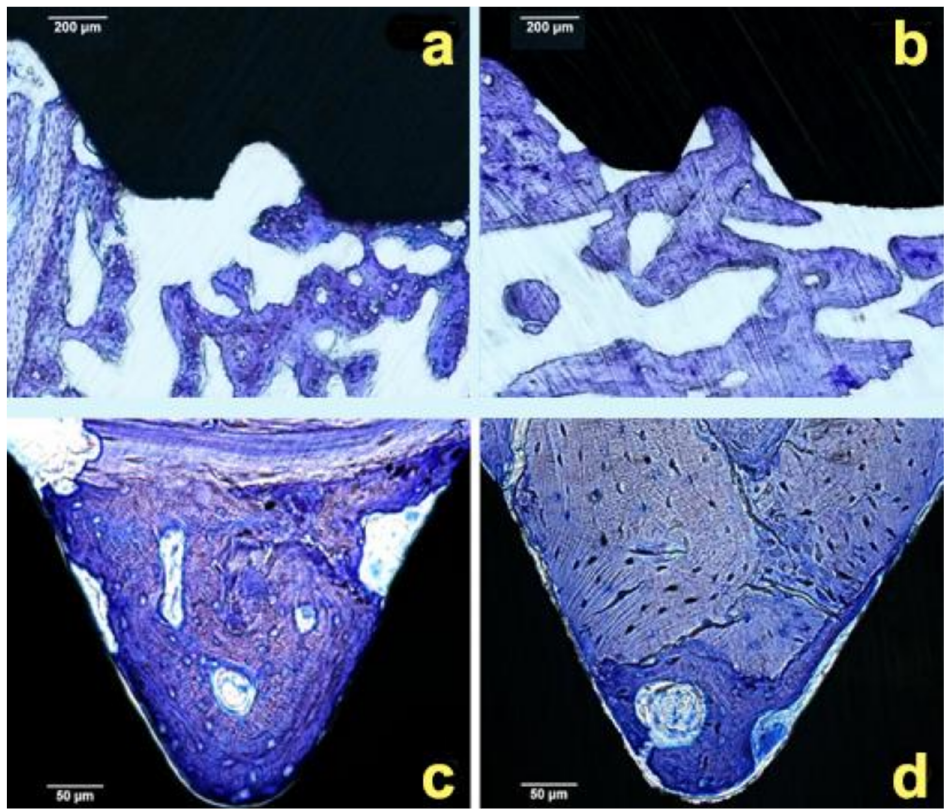
Figure 4. Bone healing proximal to the Ti ( a ) and APTES-coated ( b ) titanium implants (5 × magnifica- tion) after 3 weeks of healing. After 6 weeks, the area inside threads were fulfilled with new bone formation Ti ( c ) and APTES-coated ( d ) titanium implants (20 ×